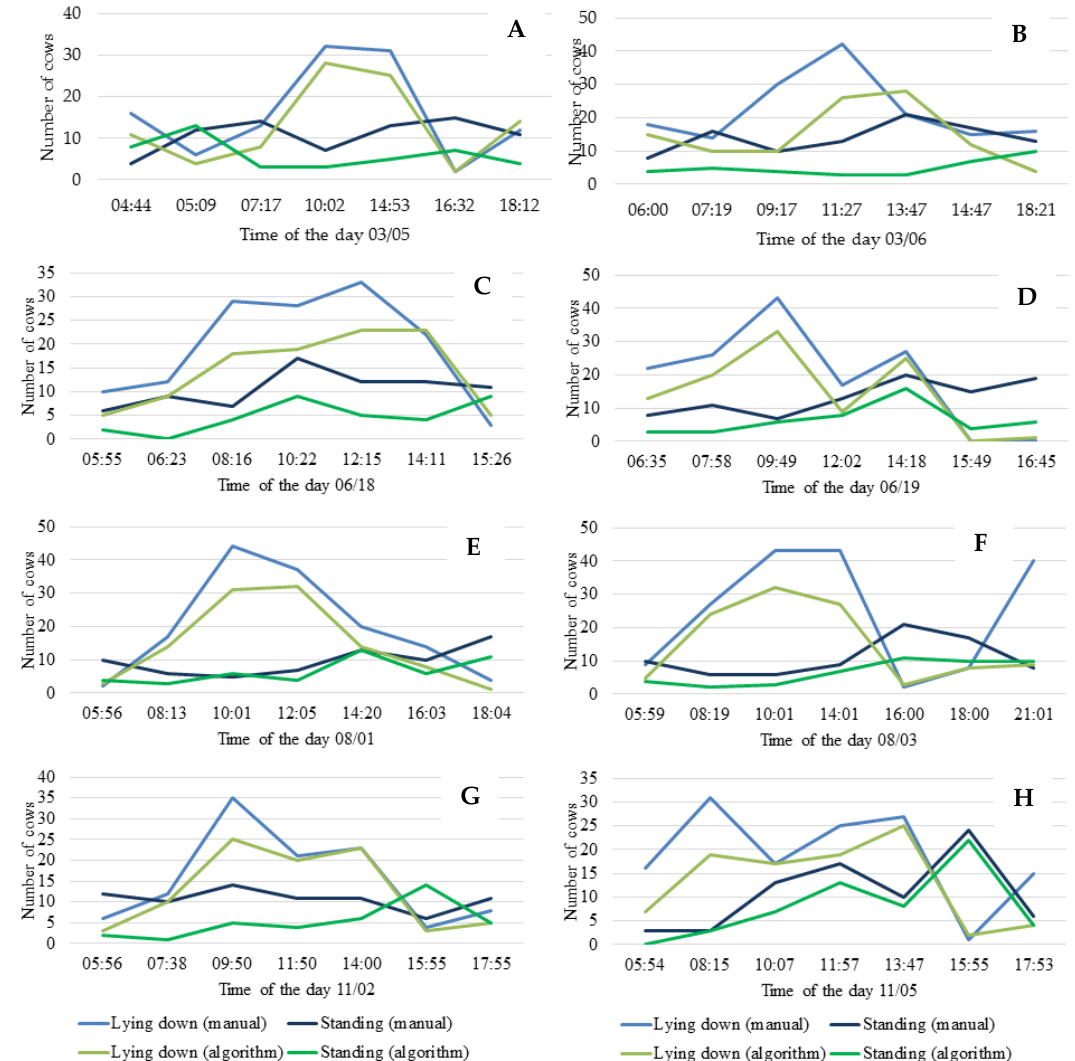
Figure 8 . Behavior trend for cows lying down and standing with manual counting and counting by algorithm during summer on 03/05 ( A ) and 03/06 ( B ), in autumn on 06/18 ( C ) and 06/19 ( D ), in winter on 08/01 ( E ) and 08/03 ( F ), and in spring on 11/02 ( G ) and 11/05 ( H ).